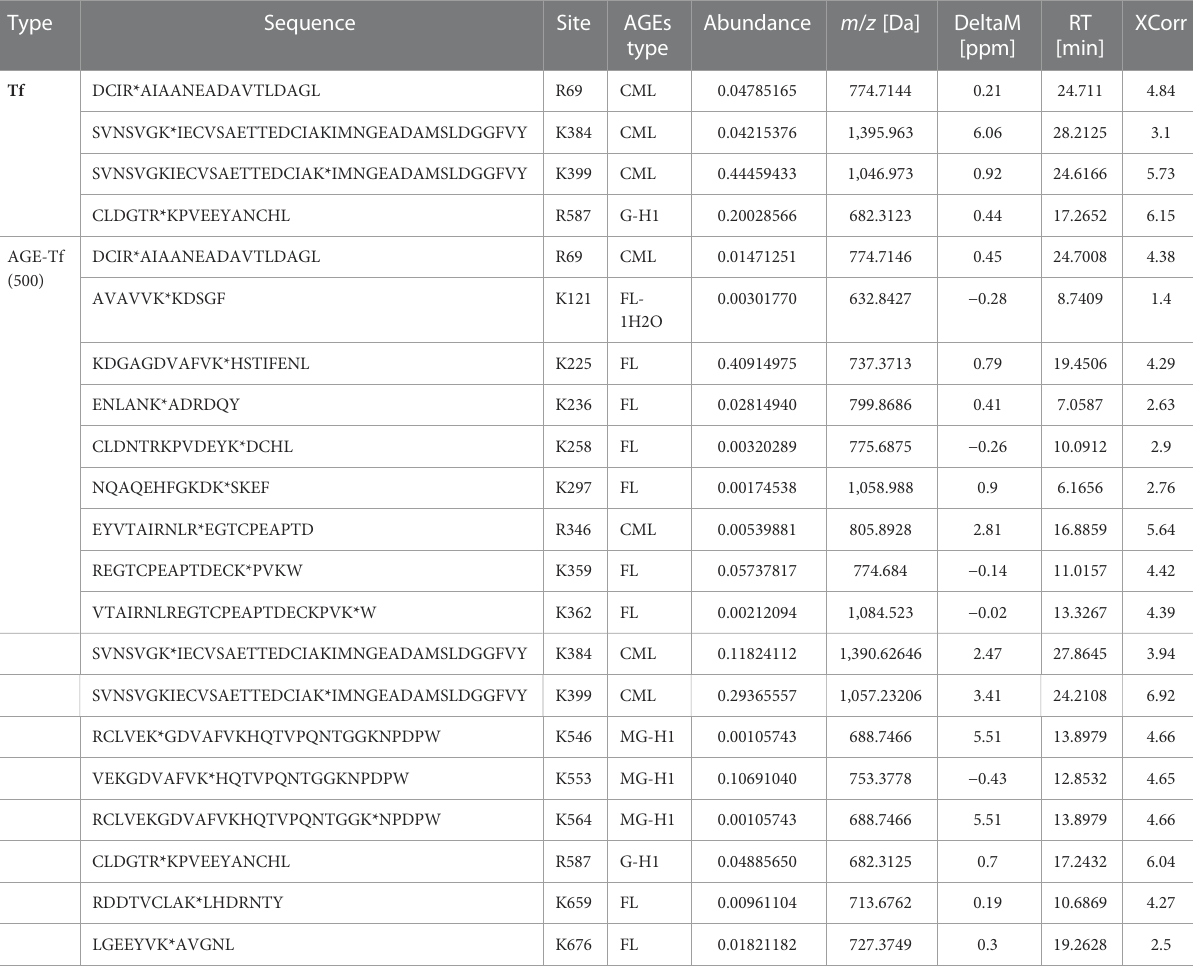
TABLE 1 Identi fi cation of Tf glycation sites by LC-MS/MS.